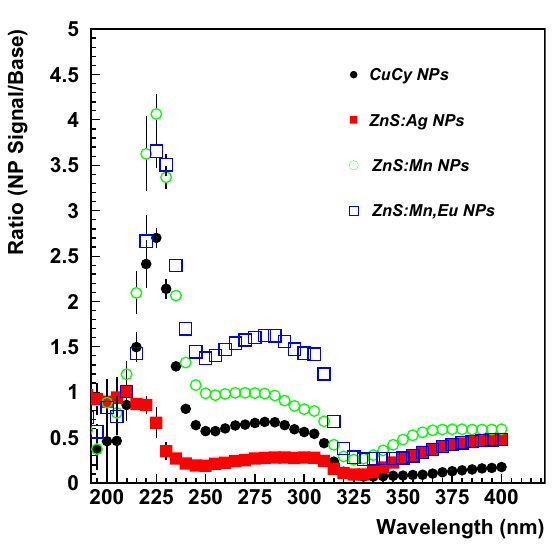
Figure 7. Ratio of nanoparticle to no nanoparticle response for 4 samples deposited on transparent